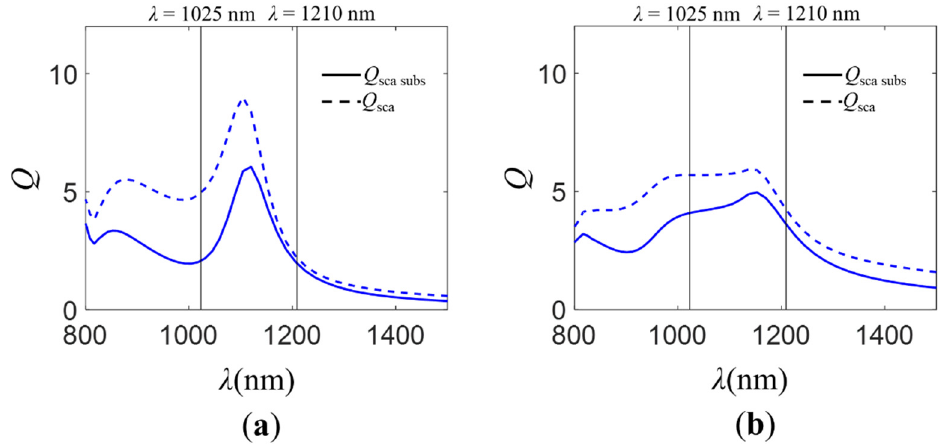
Figure 5. Total normalized scattering cross-section, Q sca (dashed line), and normalized scattering cross-section for radiation scattered into the substrate, Q sca subs (solid line), for different configurations of HRID particles on a graded-index multilayer substrate. ( a ) Isolated silicon NP of radius R = 150 nm. ( b ) Dimer of silicon NPs of radius R = 150 nm and gap distance d = 10 nm. The substrate consists of two dielectric layers of thicknesses ( t ) and refractive indices ( n ) t 1 = 185 nm, t 2 = 104 nm and n 1 = 1.396 and n 2 = 2.474, respectively, on a silicon layer ( n s = 3.5). The structures were illuminated by an unpolarized plane wave propagating normally to the surface of the substrate. Vertical black lines correspond to the wavelengths where the zero-backward ( λ = 1210 nm) and near zero-forward/“near zero-backward” ( λ = 1025 nm) conditions are attained.